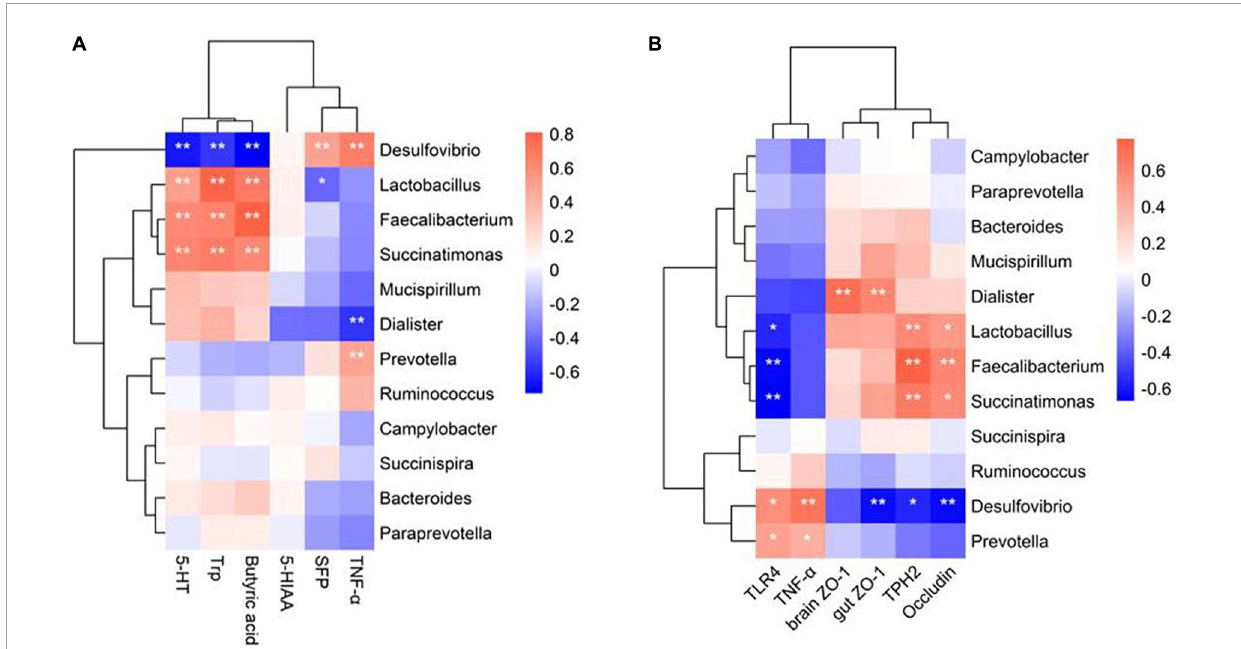
FIGURE7 Spearman’s correlations between the gut microbiota and the physiological indicators. (A) Heatmap of correlation coefficients between the intestinal microbial phylotypes of significant differences and SFP behavior, intestinal metabolite of butyric acid, 5-HT metabolism and TNF- α in the serum. (B) Heatmap of correlation coefficients between the intestinal microbial phylotypes of significant differences and Inflammation-related genes expression, and tight junction-related genes expression in the gut and brain. Red represents a positive correlation, and blue indicates negative correlations. * P < 0.05, ** P <